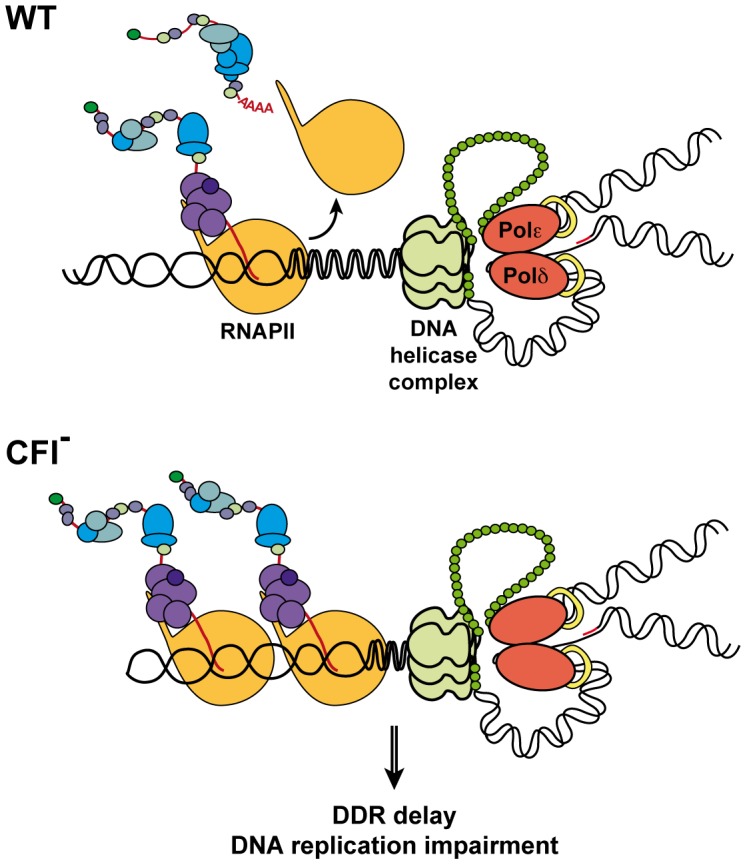
Model for concurrent transcription termination and replication processes.In wild-type cells (WT), transcription and replication are coordinated to prevent collision between both machineries and genomic instability. CFI function allows prompt DDR in the presence of DNA lesions. In CFI mutants (CFI-), impaired transcription termination interferes with replication and DDR is delayed. As a consequence, functional DNA repair pathways and G1/S checkpoint become crucial in those cells.